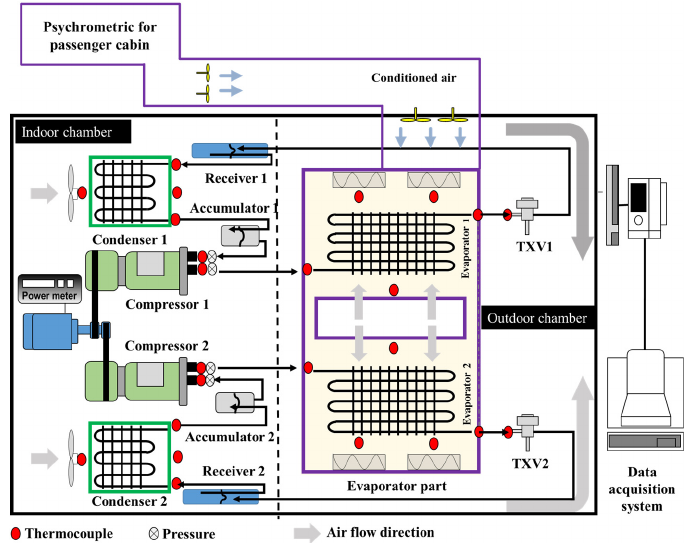
Figure 1. Schematic diagram of the experimental setup.